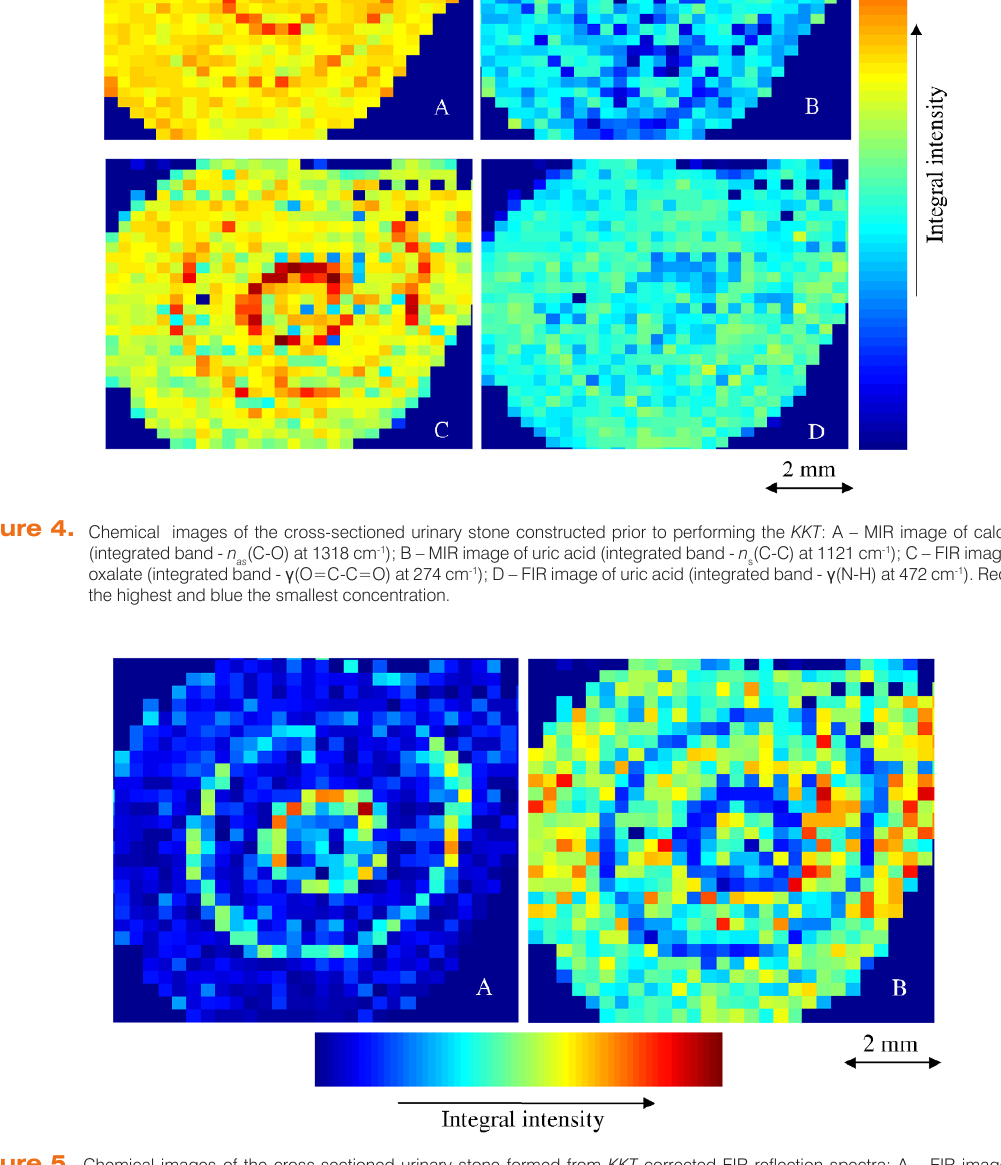
Figure 5. Chemical images of the cross-sectioned urinary stone formed from KKT corrected FIR reflection spectra: A – FIR image of calcium oxalate (integrated band - γ (O=C-C=O) at 274 cm -1 ); B – FIR image of uric acid (integrated band - γ (N-H) at 472 cm -1 ). Red represents the highest and blue the smallest